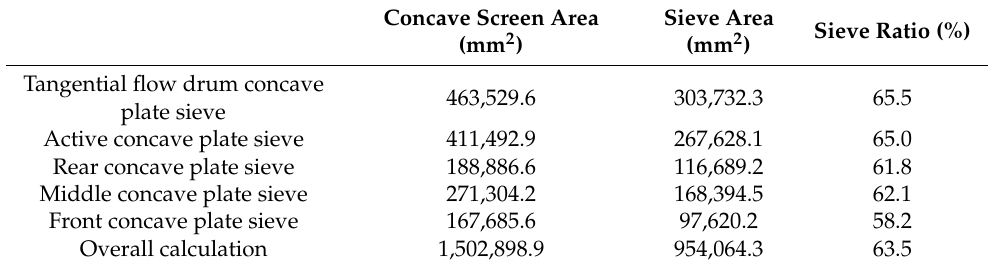
Figure 5. Concave plate sieve assembly. ( a ) The 3D model; ( b ) physical picture. According to the design data, the sieve hole rate of the concave plate screen was calculated. The lowest sieve hole rate of the rear concave plate screen was 58.2%, the highest sieve hole rate of the tangential drum concave plate screen was 65.5%, and the overall average sieve hole rate was 63.5%, which enables the model to meet the technical requirements of harvesting machinery regulations [28], as shown in Table 3. Table 3. Concave plate sieve